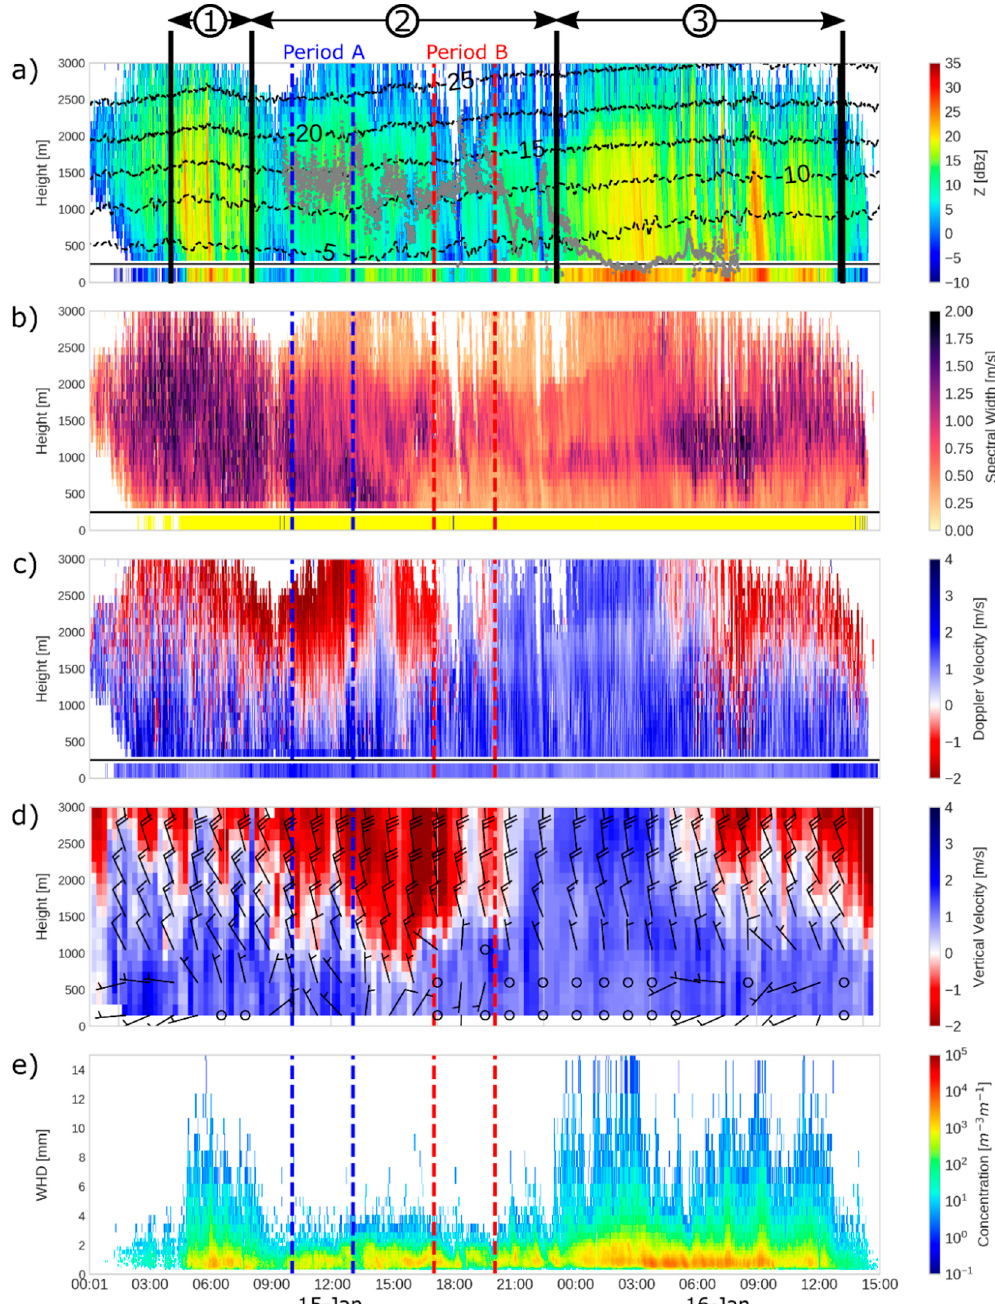
Figure 4. ( a ) Radar reflectivity [dBZ] from MRR (above black line) and Parsivel (below black line), the latter calculated assuming snow aggregates of unrimed dendrites or dendrites (see text). ( b ) Spectral Width [ms − 1 ] from MRR (above black line) and Parsivel derived type of precipitation—where snow and sleet are indicated by yellow and black colours, respectively. ( c ) Particle Doppler fall velocity [ms − 1 ] from MRR (above black line) and Parsivel measured particle fall velocity (below black line). ( d ) Inverted vertical velocity [ms − 1 ] and horizontal wind speed and direction [wind barbs in ms − 1 ] from UHF wind-profiler. ( e ) Parsivel particle concentration as a function of the widest hydrometeor diameter [m − 3 m − 1 ]. Vertical black lines in ( a ) indicate the three stages discussed in the text. Vertical blue and red dashed lines indicate the mountain wave period (Period A) and the rotor period (Period B), respectively. Dotted black lines and the grey points in ( a ) indicate microwave radiometer derived isotherm levels and cloud base height, respectively.